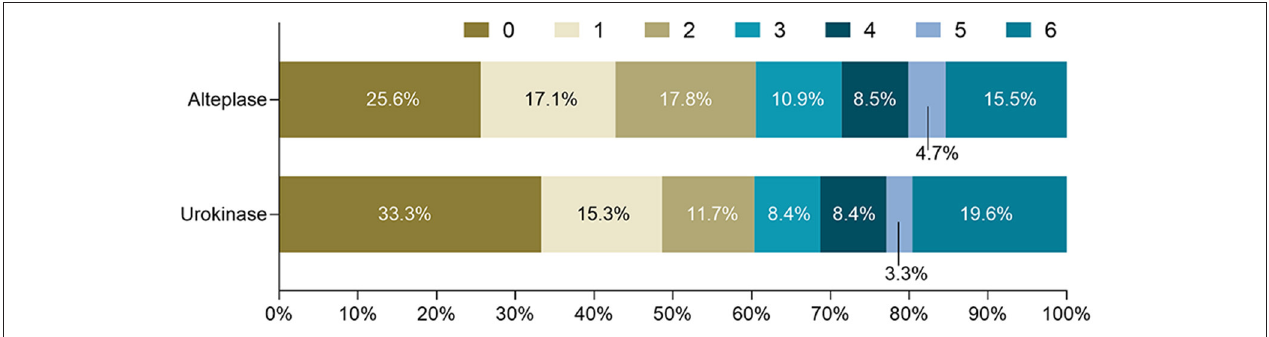
outcomes and complications compared to patients treated with